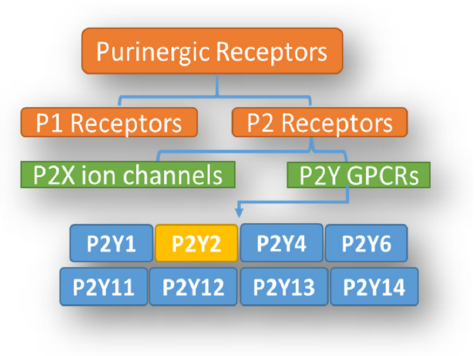
Figure 1. Purinergic receptor tree, and the classification of P2Y2: Adenosine receptors and ATP receptors (P1 and P2,